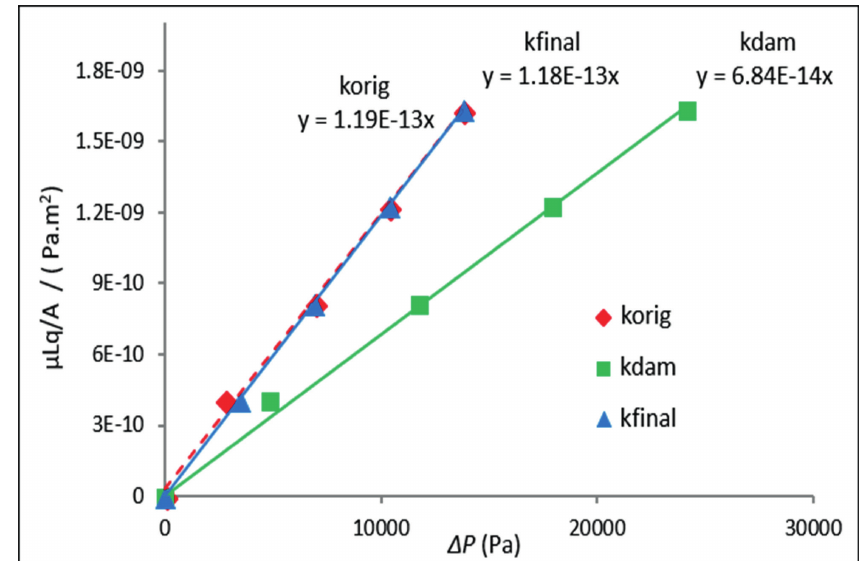
), damaged (k ), and final permeabilities (k orig dam